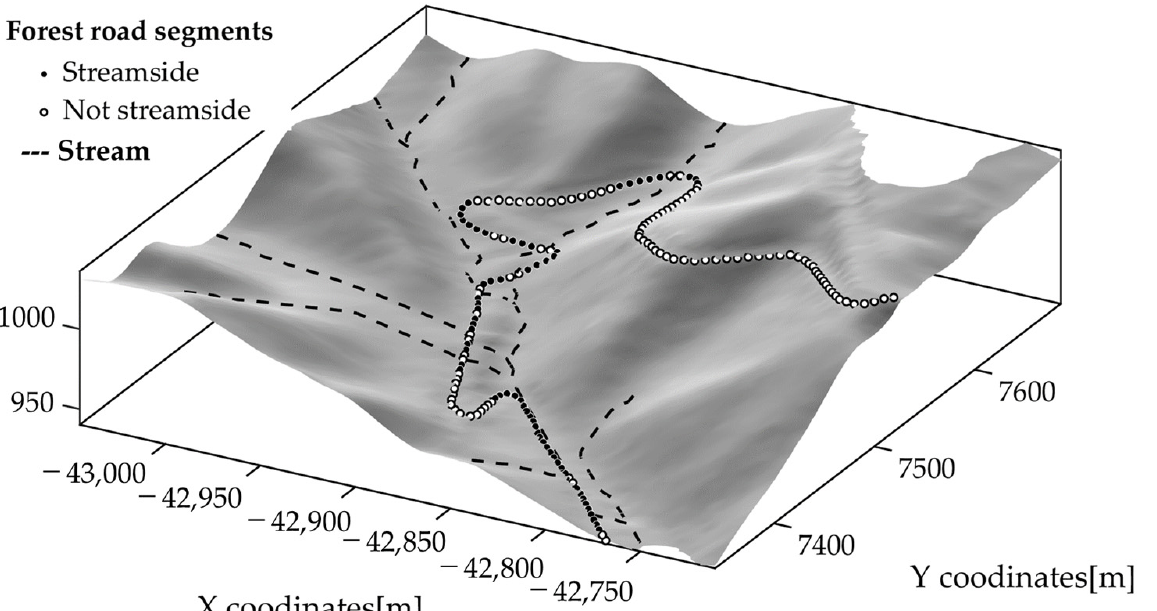
Figure 6. Image of a forest road segment that falls into the zero-order basin category. Note: The points in the figure represent the center coordinates of the segment. 2.2.1. Streamside The raster data representing the water system lines were converted into vector data, which were equally divided into 5 m intervals, as was the case with forest roads. The nearest waterline vertex was searched from each forest road vertex, and its distance was obtained. The forest road vertices within 15 m of the waterline were defined as forest road segments along the stream. In this study, stream features were created from a DEM with a 5-m cell size. Therefore, we used 15 m, the distance of 3 cells in the DEM, as a guide to represent the adjacent range of the stream. 2.2.2. Stream Crossing Stream line features and forest road line features were determined to intersect, and forest road segments that intersected were defined as stream crossings.